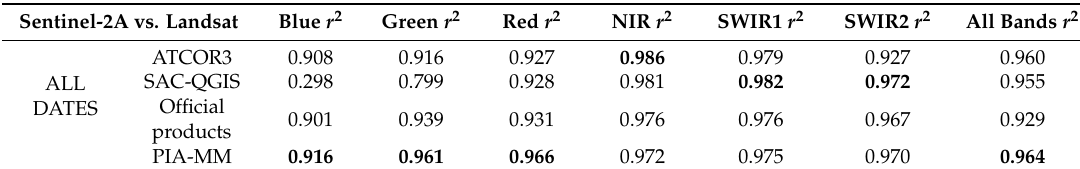
Figure 11. Band-by-band Root Mean Square Error of each radiometric correction method analyzed for Sentinel-2A images, grouping all dates. Table 7. Band-by-band coefficient of determination ( r 2 ) between simultaneous Landsat (ETM+ and OLI) and Sentinel-2A (MSI) radiometrically corrected images. Correlated values are sampled pixels. Best values in bold.